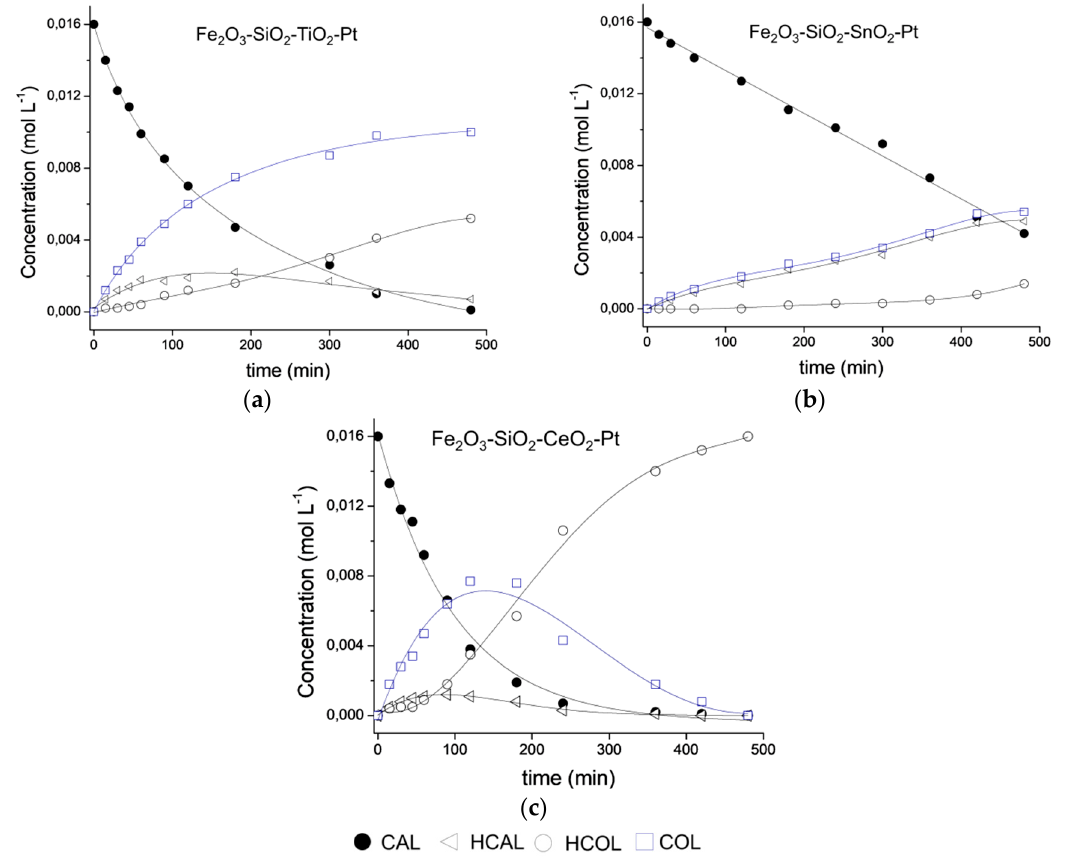
Figure 7. Product distribution during CAL hydrogenation on ( a ) Fe 2 O 3 –SiO 2 –TiO 2 –Pt, ( b ) Fe 2 O 3 –SiO 2 –SnO 2 –Pt and ( c ) Fe 2 O 3 –SiO 2 –CeO 2 –Pt catalysts.